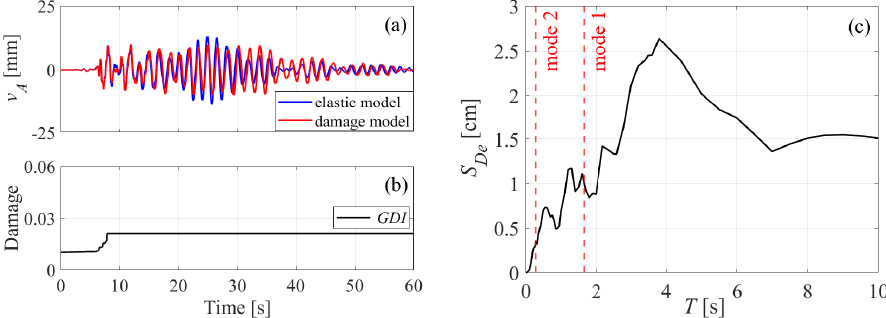
Figure 17. Earthquake MZ19 station: ( a ) elastic and damage responses of the equivalent pier, ( b ) evolution of the GDI , ( c ) elastic displacement spectrum.